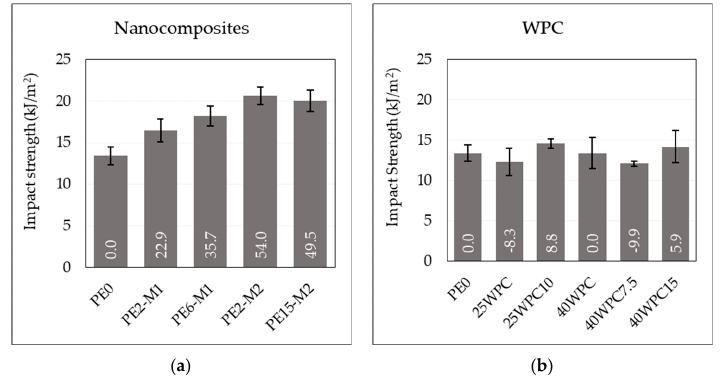
Figure 3. Impact strength of ( a ) the nanocomposites, and ( b ) the wood polymer composite at different graphene and wood fiber loadings. Data labels represent the percentage change with respect to neat polymer.